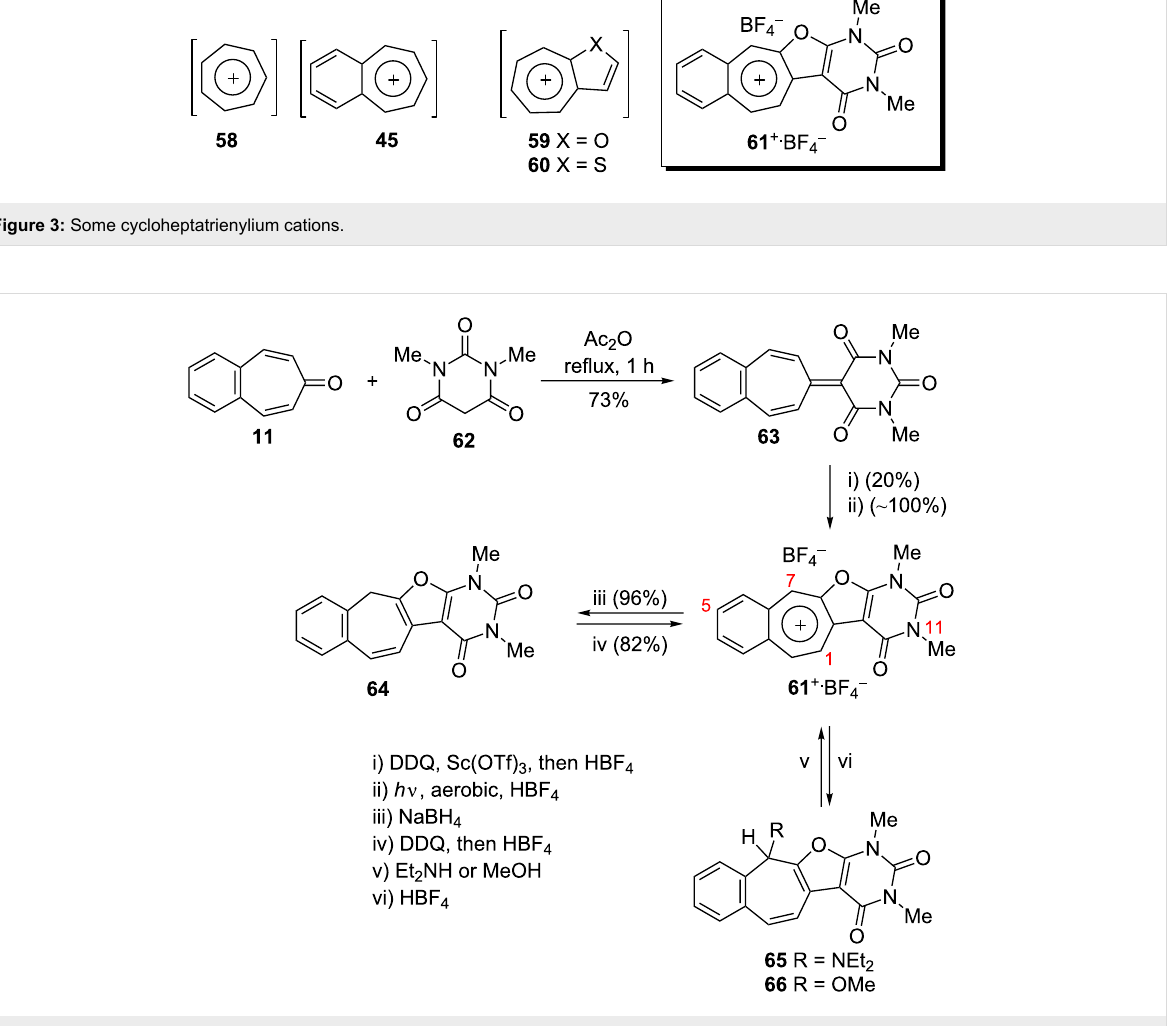
Scheme 12: Synthesis of condensation product 63 and its subsequent oxidative cyclization